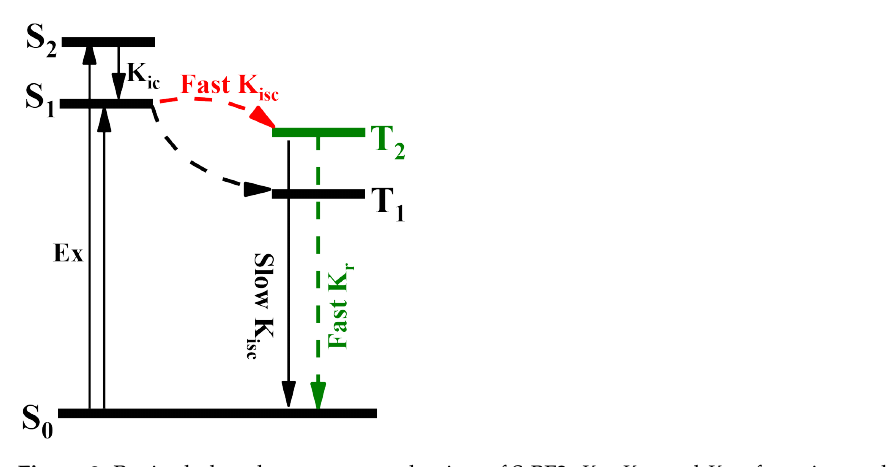
Figure 3. Revised phosphorescence mechanism of S-BF2. K ic , K isc and K r refer to internal conversion rate, intersystem crossing rate, and radiative rate, respectively.